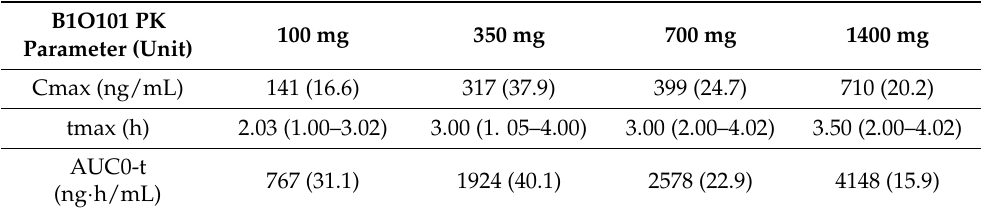
Table 4. Kinetic parameters of BIO101 (=97% pure 20E) after a single oral administration ( n = 6, fasted). Values in parentheses indicate the SEM (C max , AUC) or the range (t max ).